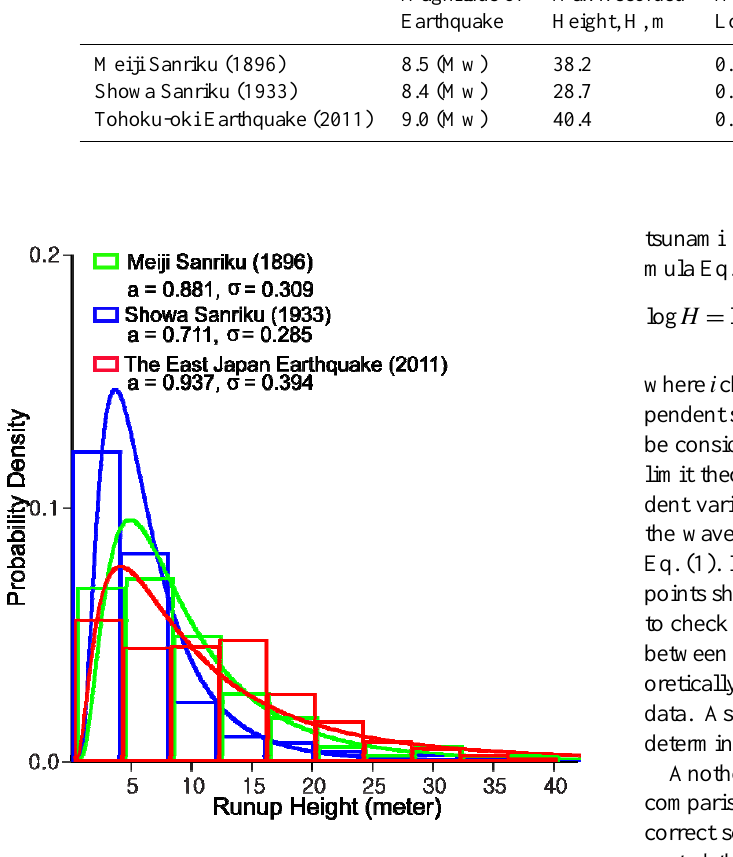
Figure 2. Histograms of three tsunamis with interval 4 m of runup height 15